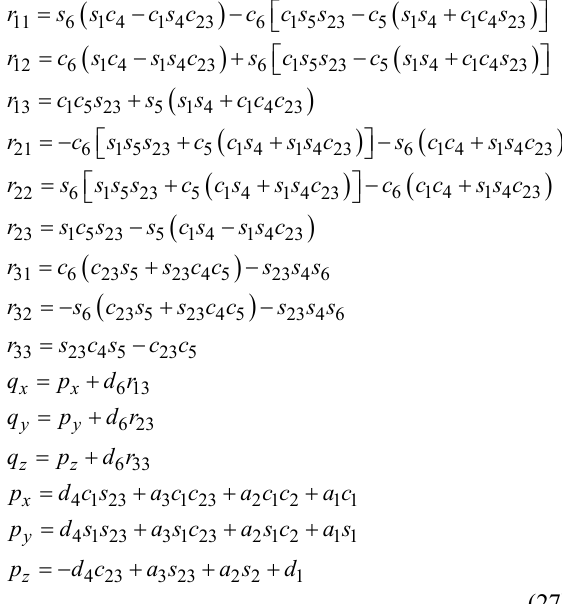
Figure 11. Robot